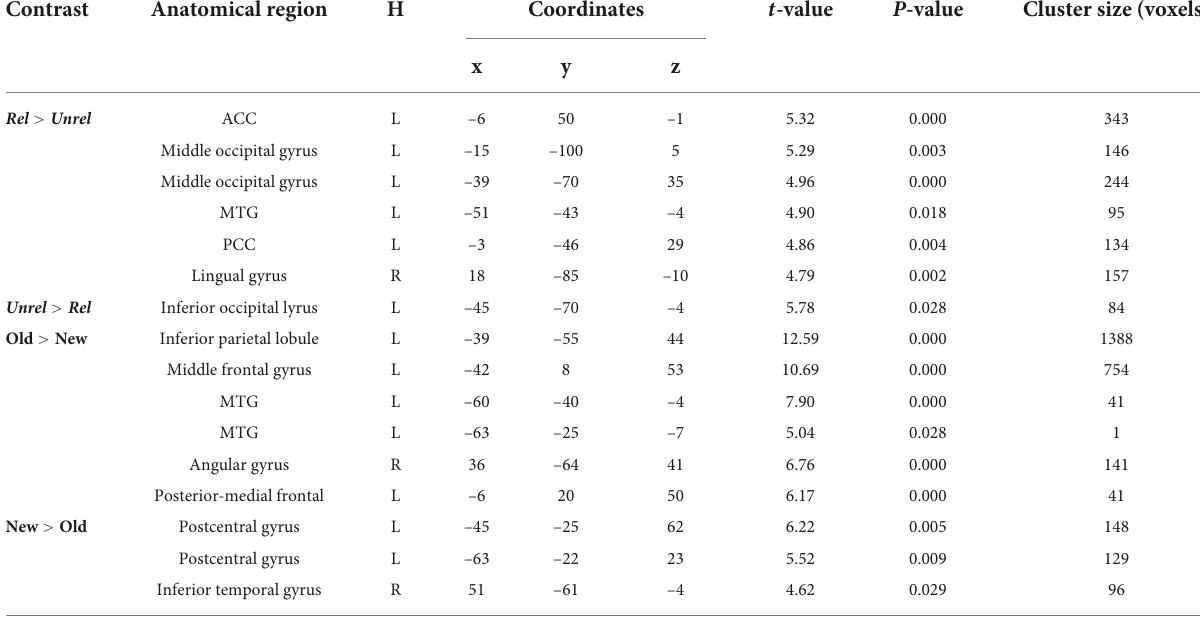
TABLE 3 Picture recognition: Peak coordinates of significant clusters for all contrasts.